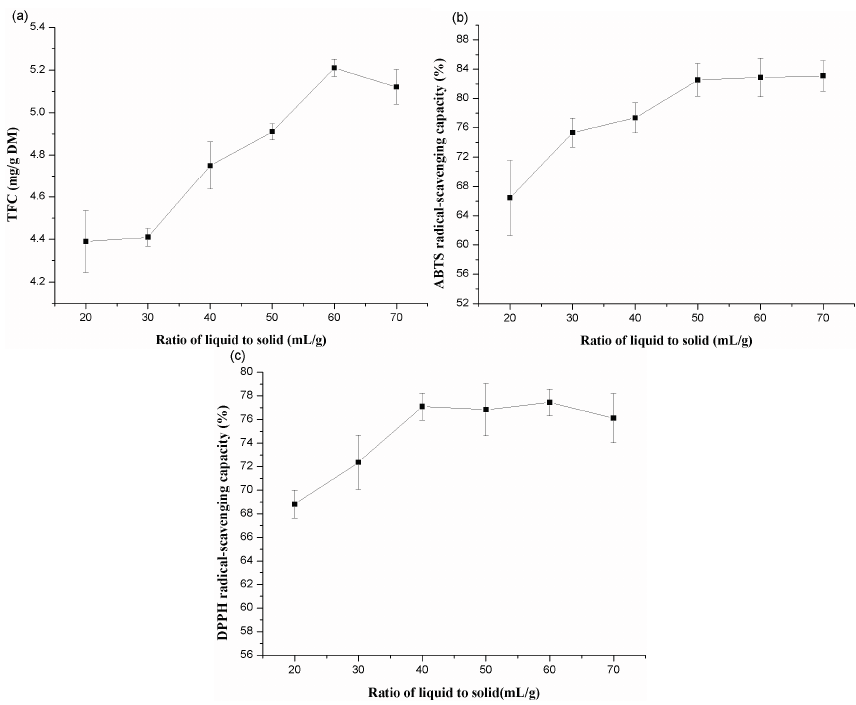
Figure 1. Effects of liquid to solid ratio on the extraction yield of total flavonoids ( a ); ABTS ( b ) and DPPH ( c ) radical-scavenging capacities of extracts from